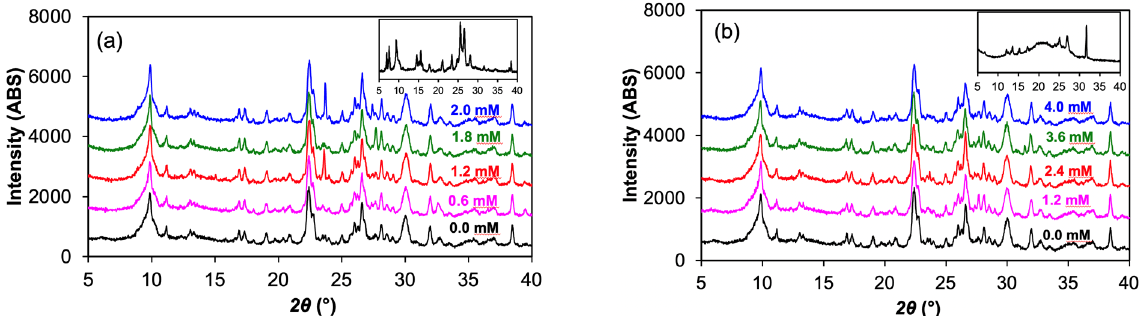
Figure 5. XRD patterns of ZEO after sorption from binary ( a ) and single TB ( b ) solution of different initial concentrations. The insets are the XRD patterns of solid SO ( a ) and TB ( b ).